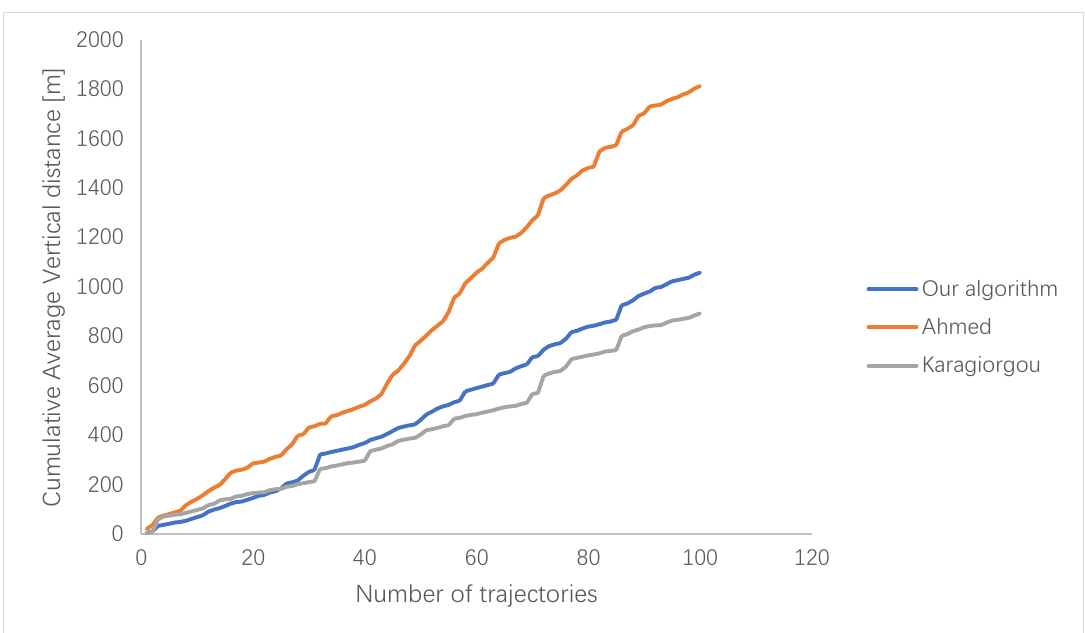
Figure 18. Cumulative Discrete Fréchet distance.